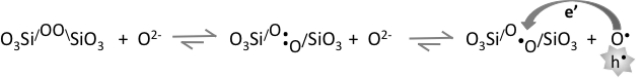
(a) The stressed rock volume turns into the source of charge carriers. The positive holes h• flow out into the unstressed rock, creating an electrical potential like in a battery. (b) The battery circuit can be closed by running a wire from the pistons (which are in contact with the stressed rock) to the unstressed end of the rock.